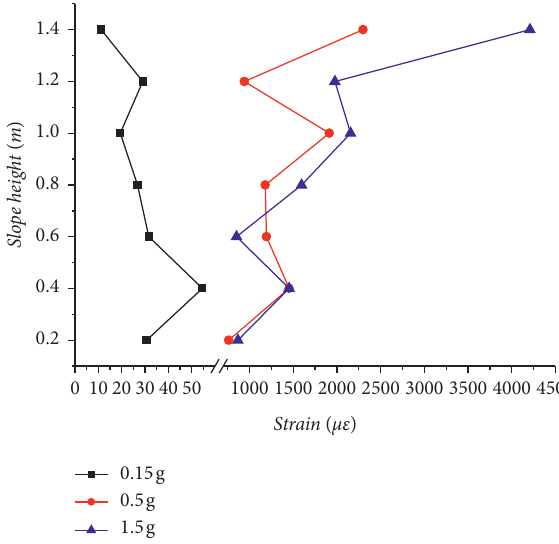
Figure 9: Geogrid strain distribution along the slope height.